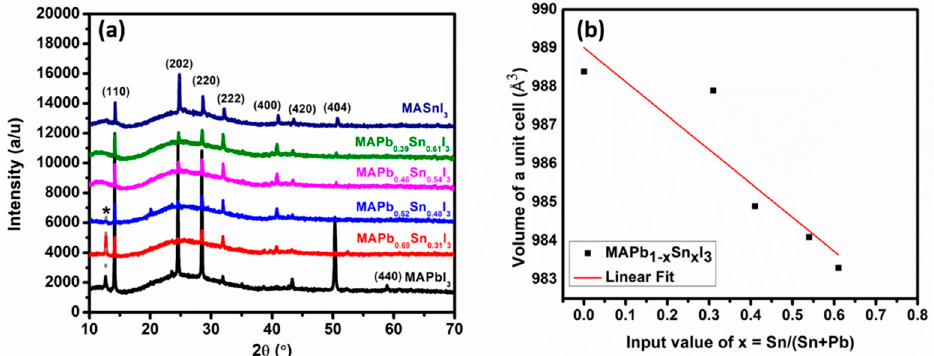
Figure 6. ( a ) X-ray diffraction pattern and ( b ) the evolution of the volume of the unit cells upon increasing content Sn. The linear fit is used to give direction to the eye.